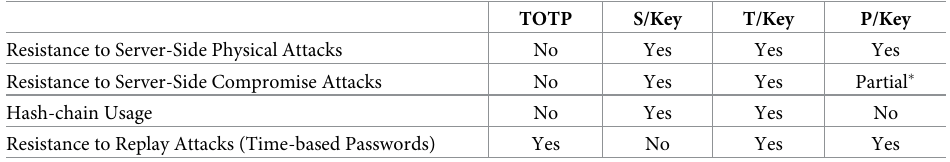
Table 3. Comparison of the proposed protocol with various protocols.